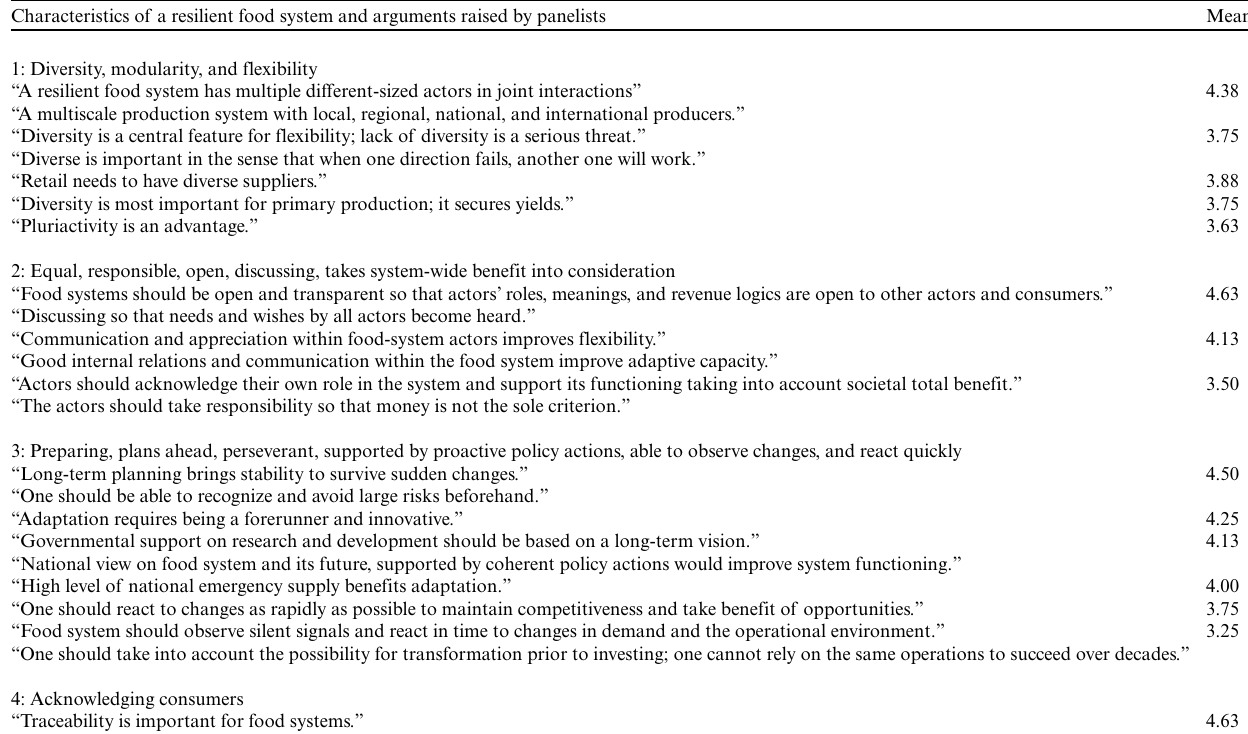
Table 3 . Thematic analysis of the main characteristics of a resilient food system for Finland, based on answers given by the Delphi panelists (n = 12-18). The mean values (on a scale from total disagreement (1) to total agreement with the argument (5)) show the degree of convergence of opinions regarding representative and selected arguments raised by the panelists in Delphi round 1, which were reassessed in round 2. The characteristics are not exclusive of each other, but rather provide multiple approaches to enhancing